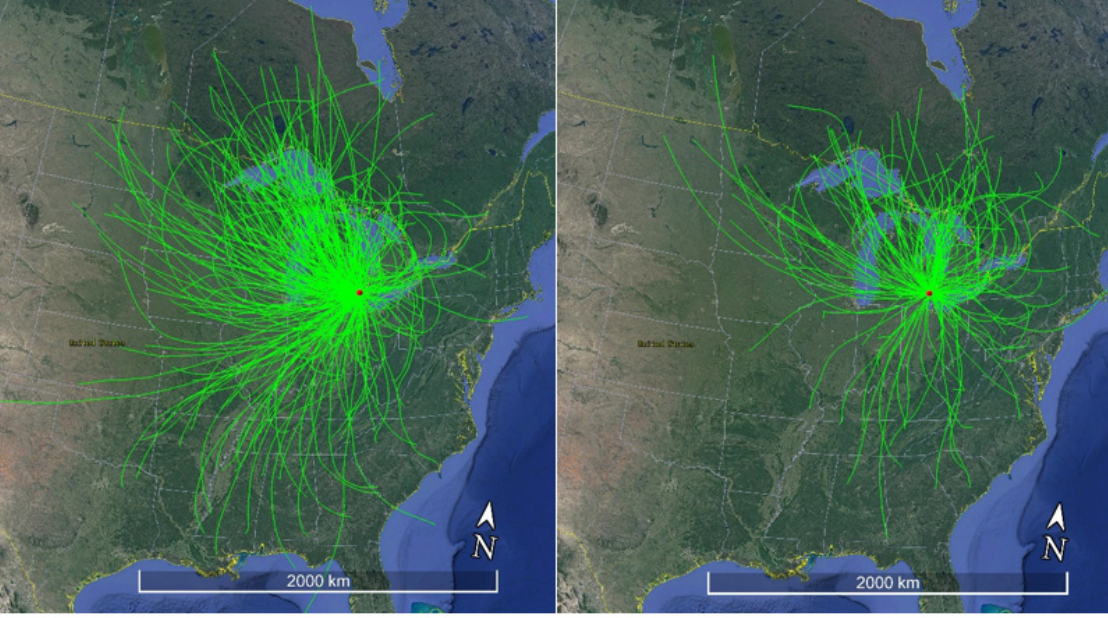
Figure 4. Back trajectories of AQHI < 3 days in cold season ( left ) and warm season ( right ). The red dot is Windsor. Figure 5 depicts back trajectories (348 in the warm season and 364 in the cold season) with AQHI = 3. Days with AQHI = 3 were associated more with air masses from the northwest,